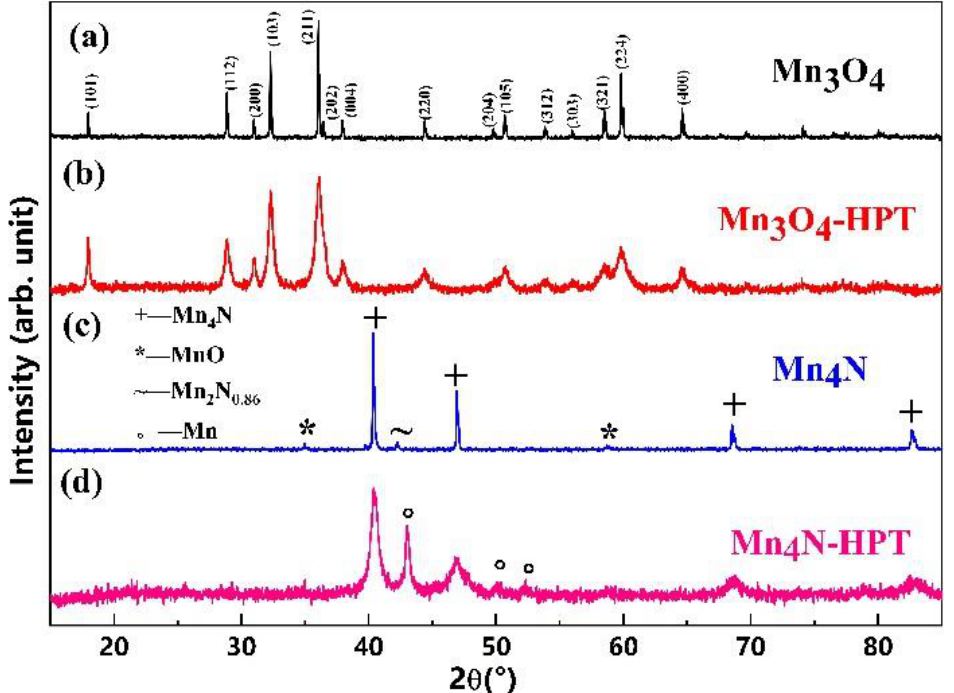
Figure 3. The XRD patterns of the Mn 3 O 4 precursor ( a ), and the Mn 3 O 4 after HPT with the numbers of rotations n = 3 ( b ), Mn 4 N precursor ( c ), and the Mn 4 N after HPT with the numbers of rotations n = 3 ( d ).